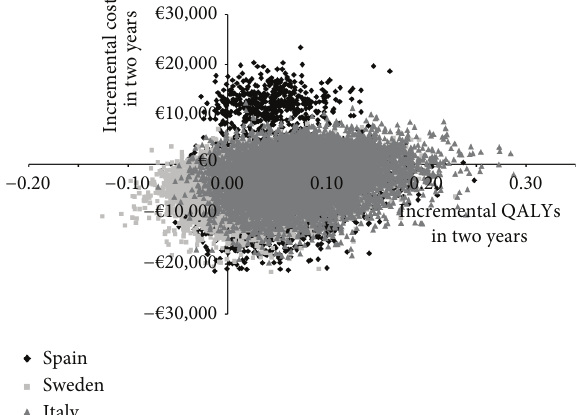
Figure 4: Scatterplot of the incremental cost effectiveness of dox- orubicin/ifosfamide compared to trabectedin monotherapy (10,000 iterations of each model).